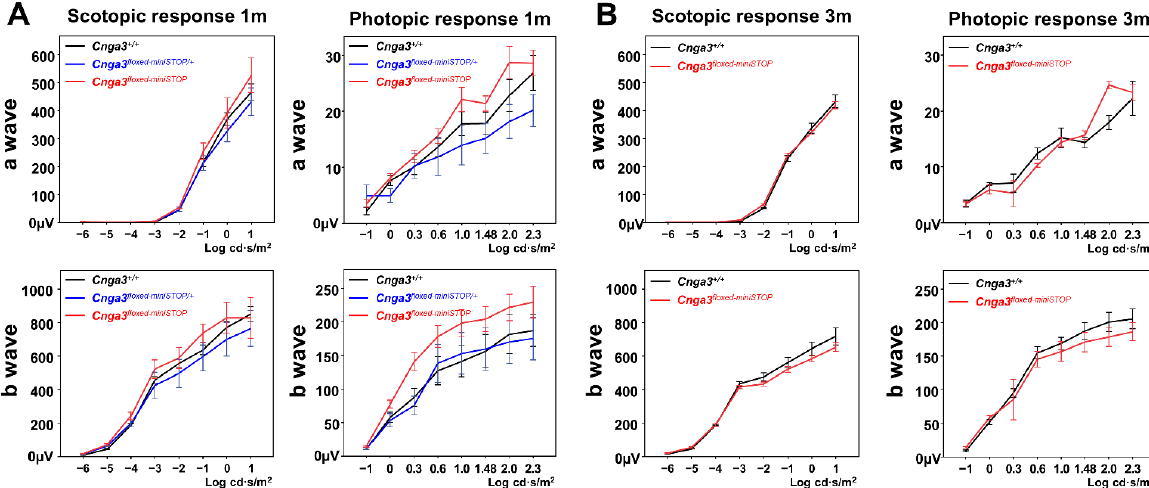
Figure 3. Electroretinography (ERG) of Cnga3 floxed-miniSTOP mice. ( A ) Scotopic and photopic serial intensity ERG tracings of Cnga3 floxed-miniSTOP mice showed no decrease in b- wave amplitudes compared to the Cnga3 +/+ and Cnga3 floxed-miniSTOP/+ mice from the same litter at 1-month old (n Cnga3+/+ = 3, n Cnga3floxed-miniSTOP/+ = 2, n Cnga3floxed-miniSTOP = 5). ( B ) Scotopic and photopic serial intensity ERG of Cnga3 floxed-miniSTOP mice showed no decrease in b -wave amplitudes compared to the Cnga3 +/+ mice from the same litter at 3 months old (n Cnga3+/+ = 3, n Cnga3floxed-miniSTOP = 3).